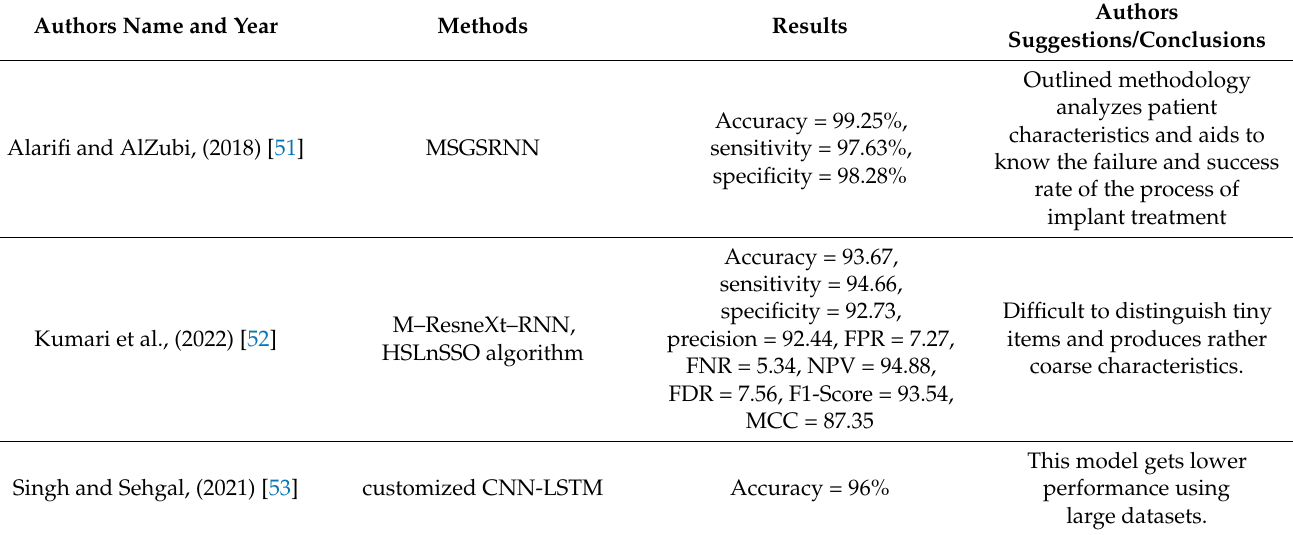
Table 4. RNN Selected